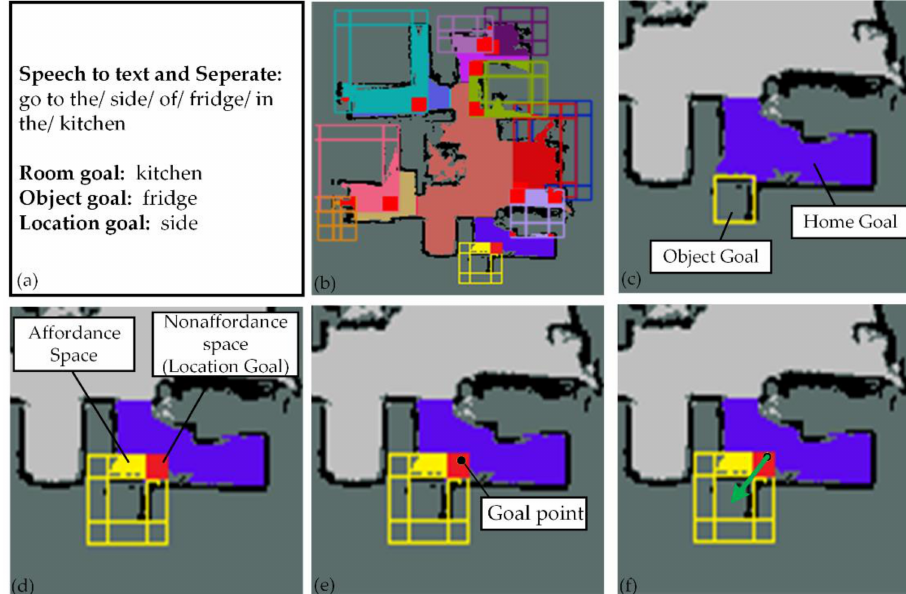
Figure 3. Automatic selection of navigation goal: ( a ) Word segmentation and concept query. ( b ) Object semantic grid and topological map. ( c ) Target object and target room. ( d ) The a ff ordance space and nona ff ordance space of the object goal. ( e ) Navigation goal point. ( f ) Goal